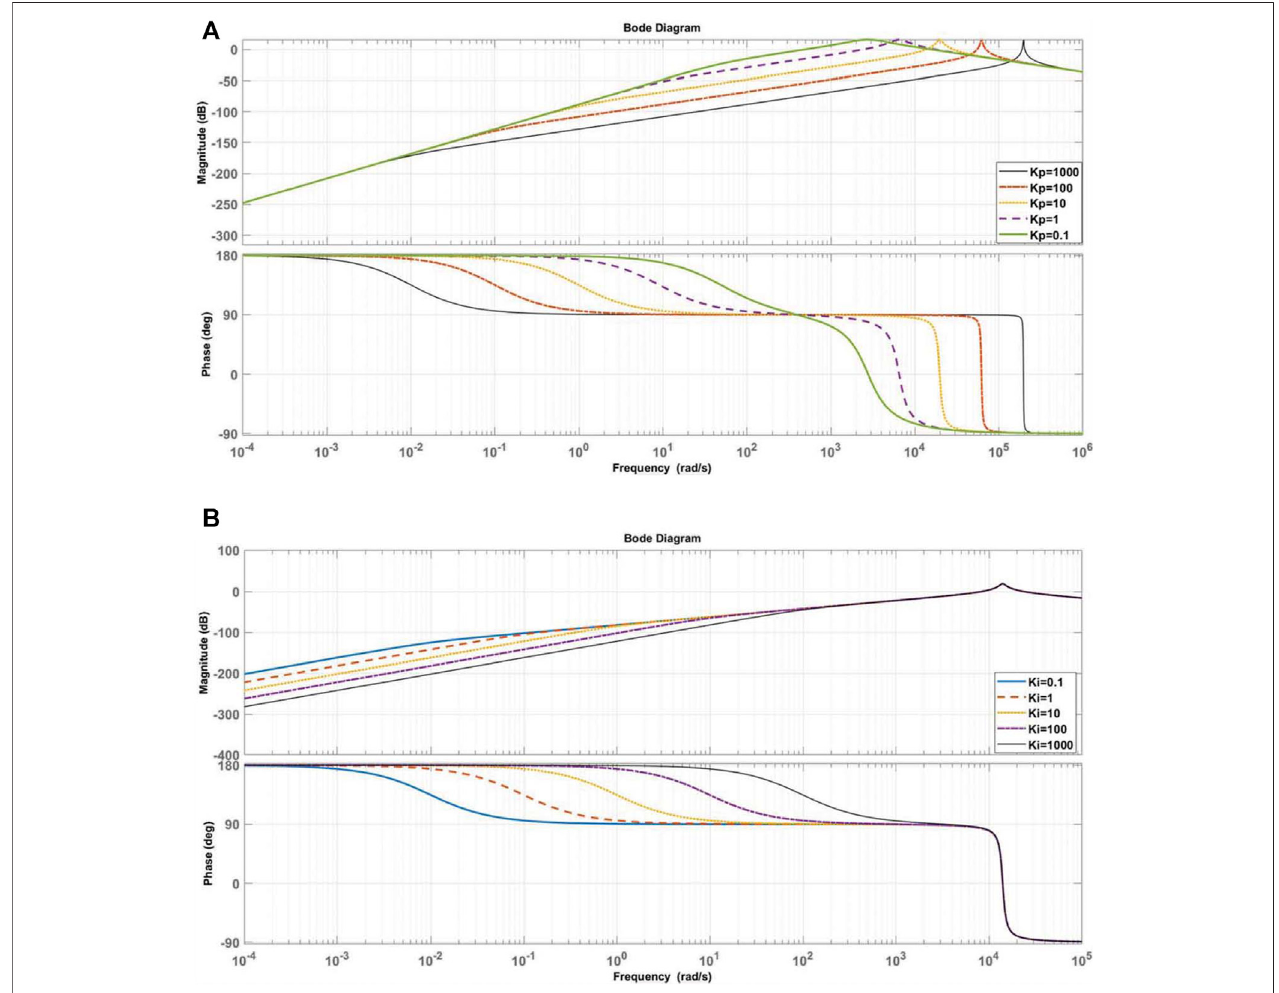
FIGURE 3 | Bode diagram of output impedance Z o ( s ). (A) Bode diagram of with different parameter K up . (B) Bode diagram of with different parameter K ui .